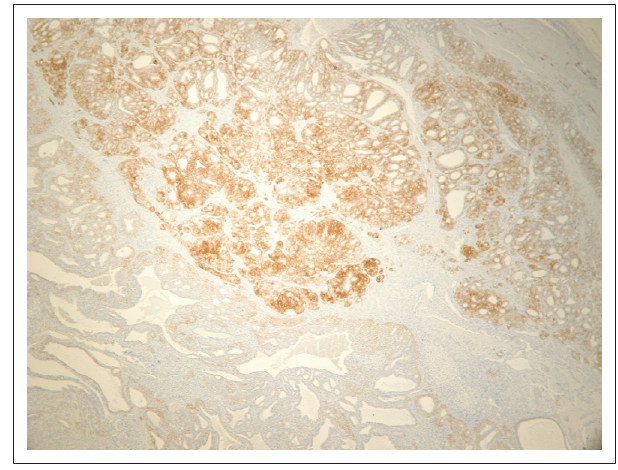
Magnification: 4×. FIGURE 3: Micrograph of the thyroid carcino-sarcoma stained with cytokeratin.